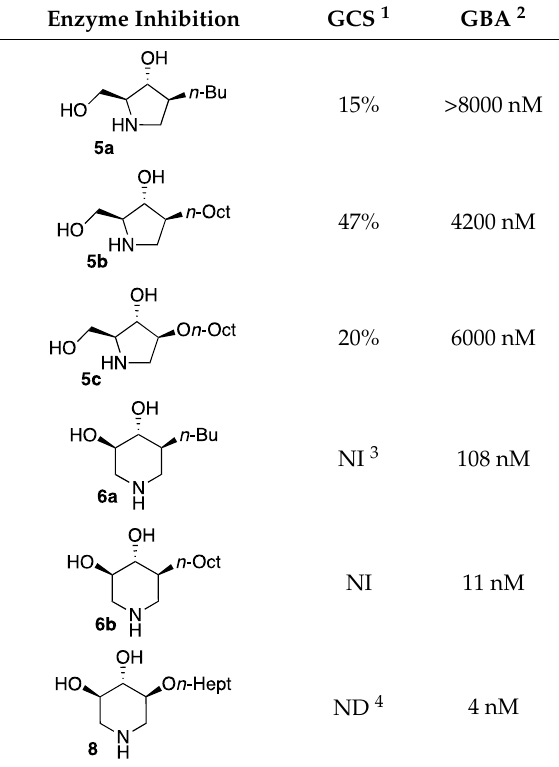
Table 2. Effect of iminosugars on GCS and GBA inhibition.